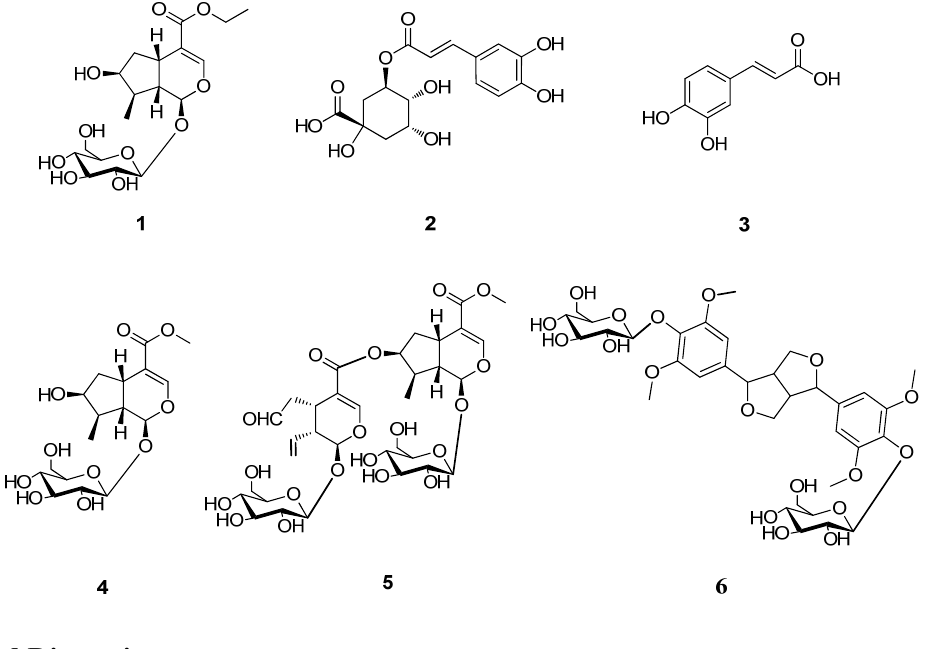
Figure 1. The chemical structures of compounds 1 – 6